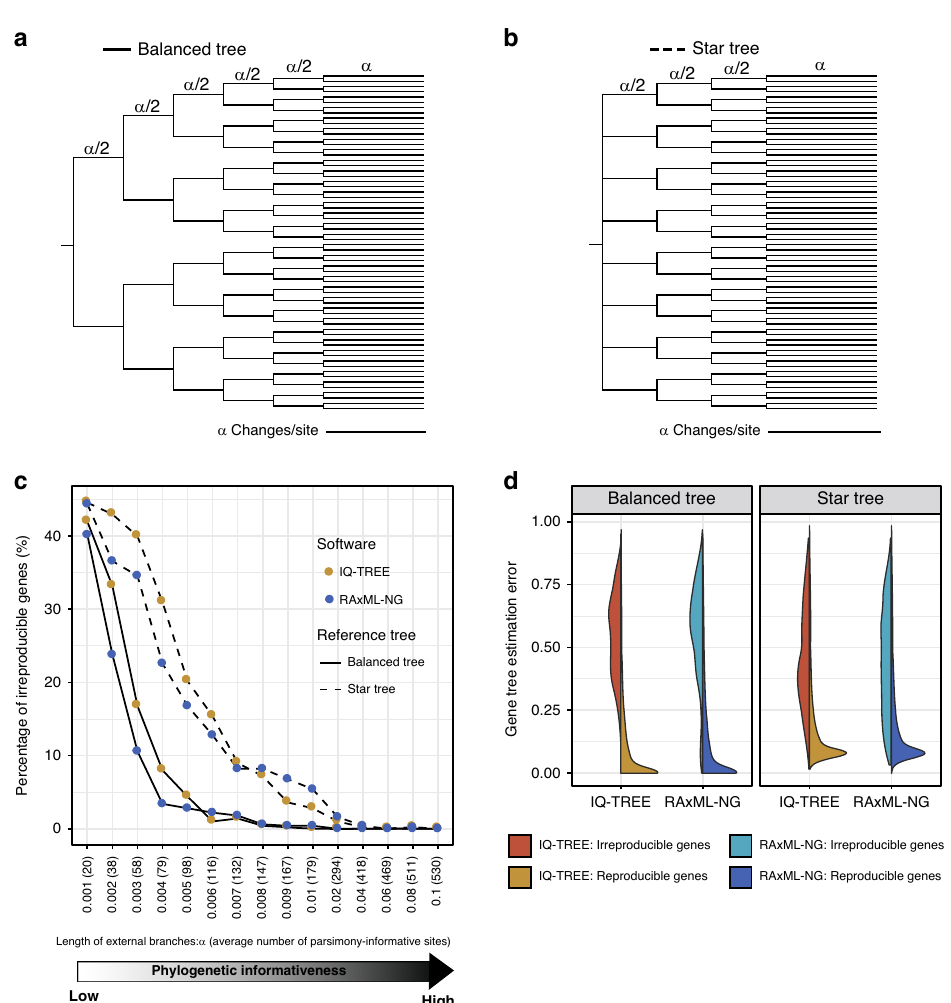
Fig. 6 The topologies of genes yielding irreproducible phylogenies are more likely to be incorrect than those of genes yielding reproducible phylogenies. To examine whether genes yielding irreproducible phylogenies were more likely to be incorrect than genes yielding reproducible phylogenies, we simulated gene sequence alignments on 30 phylogenetic trees (15 balanced trees and 15 star trees with 64 taxa) that were scaled by branch length α (where α = 0.001, 0.002, 0.003, 0.004, 0.005, 0.006, 0.007, 0.008, 0.009, 0.01, 0.02, 0.04, 0.06, 0.08, or 0.1). Each phylogenetic tree was used to simulate 500 nucleotide sequence alignments, varying randomly in length from 300 to 1000 base pairs using Seq-Gen under the GTR model (-mGTR -a1 -g4 -i0 -f0.25,0.25,0.25,0.25 -n1 -or). For each of the 15,000 sequence alignments (30 phylogenetic trees * 500 sequence alignments), we assessed its reproducibility between two replicates (Run1 and Run2) on two separate nodes (i.e., each analysis was run on a single node, but Run1 was executed on a different node than Run2) using two threads on the CHTC cluster. a Balanced species tree of 64 taxa. Lengths of all external branches and internal branches are α and α /2, respectively. b The star species tree of 64 taxa is a balanced species tree with six zero-length internal branches near the root. c Percentage of genes that yielded irreproducible phylogenies plotted against α value of reference tree used in the simulation. d Comparison of gene tree estimation error between genes yielding irreproducible phylogenies and genes yielding reproducible phylogenies. Gene tree estimation error corresponds to the normalized Robinson – Foulds tree distance (nRFD) between the inferred tree and the reference tree. Genes yielding irreproducible phylogenies are colored in red and genes yielding reproducible phylogenies are colored in yellow when using IQ-TREE; genes yielding irreproducible phylogenies are colored in green and genes yielding reproducible phylogenies are colored in blue when using RAxML-NG. This comparison shows the genes that generate irreproducible phylogenies are more likely to be incorrect than genes that generate reproducible phylogenies. We observed a similar magnitude of gene tree estimation error (even though irreproducibility for IQ-TREE was two-fold higher) when using three threads per node. The 15 balanced trees, the 15 star trees, command lines, gene alignments, and gene trees, as well as statistics of the results, are available on the fi gshare repository: https://doi.org/ 10.6084/m9. fi The genes that yield irreproducible phylogenies are more likely to be incorrect . Since the true species and single-gene phylo- 0.1), respectively; trees with larger α values had higher rates of genies for the 15 empirical phylogenomic data sets are unknown, substitutions per site and, consequently, higher average numbers it is impossible to assess whether irreproducible phylogenies are of parsimony-informative sites (Fig. 6a, b). We then used each of more or less similar to the true phylogeny than reproducible ones. these 15 balanced and 15 star trees to simulate 500 nucleotide To address this question, we simulated DNA sequence alignments sequence alignments that varied in length under the GTR + G4 on 15 balanced trees and 15 star trees, both with 64 taxa. Each model (detailed parameters are given in the fi le entitled “ Seq_- tree was scaled by branch length α ( α = 0.001, 0.002, 0.003, 0.004, Gen_run.bat ” on the fi gshare repository: https://doi.org/10.6084/